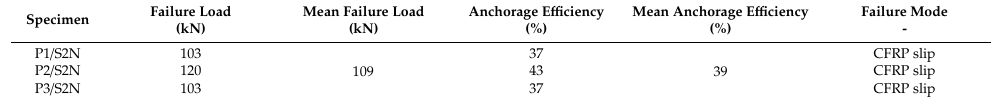
Figure 14. Load-displacement plots for all the specimens in the S2N series. Table 4. Test results of the specimens tested in S2N series.